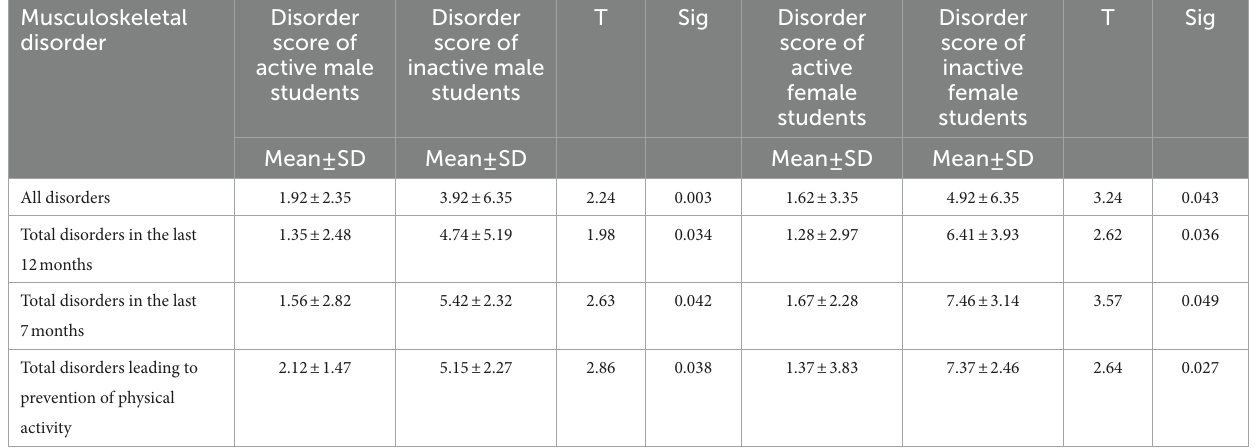
TABLE 3 Description and comparison of skeletal and muscular